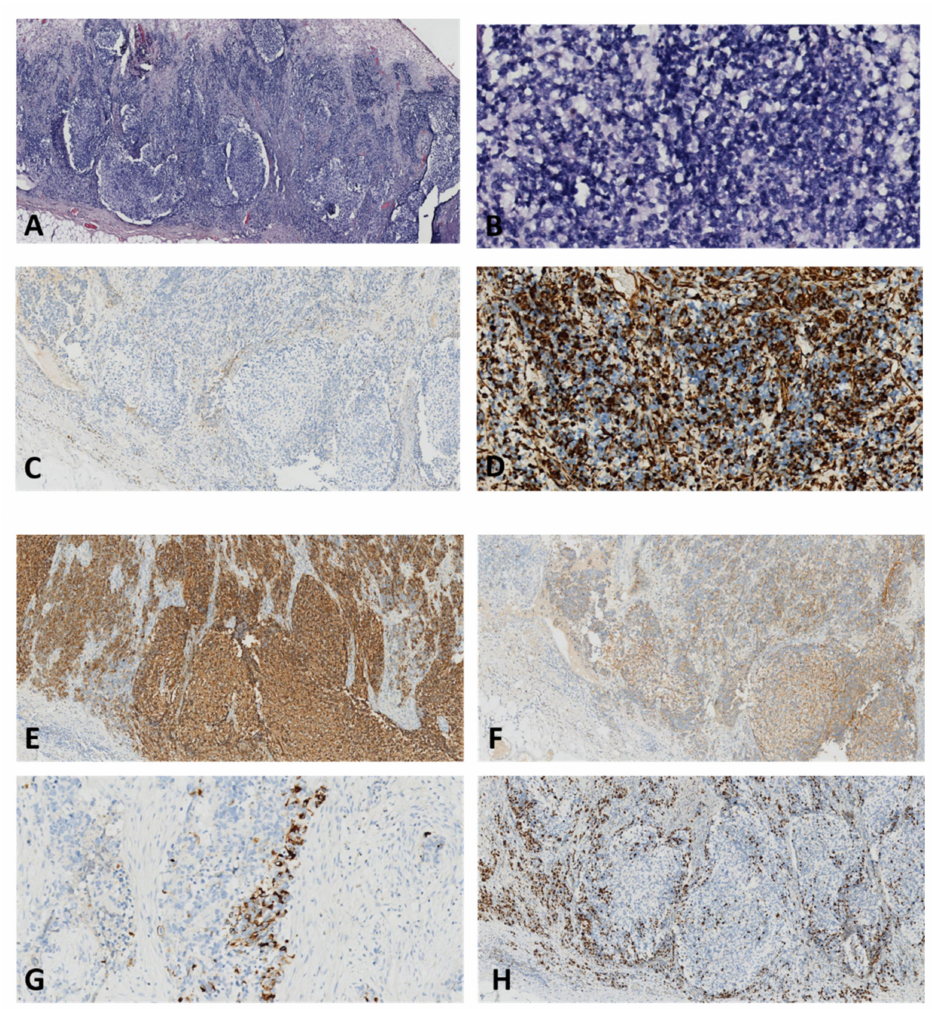
Figure 14. Teratomas with malignant transformation, medulloblastoma type: ( A ) Poorly differenti- ated small cell proliferation with microinsular and diffuse pattern (HE, × 20 magnification); ( B ) Poorly differentiated small cell proliferation with hyperchromatic nuclei (HE, × 170 magnification); ( C ) Ep- CAM negative ( × 40 magnification); ( D ) Vimentin positivity in tumor cells ( × 100 magnification); ( E ) CD56 positivity in tumor cells ( × 40 magnification); ( F ) Synaptophysin positivity in tumor cells ( × 20 magnification); ( G ) Focal-GFAP positivity in tumor cells ( × 100 magnification); ( H ) Proliferation index with marginal zonation (Ki67, × 40 magnification). (Courtesy of Dr. M.